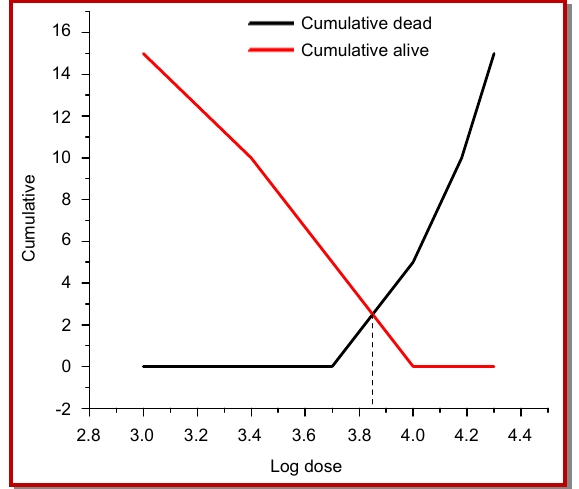
Log Figure 1: Determination of LD 50 using cumulative dead of the mice and cumulative mice that are alive (Colegate et al., 1993)